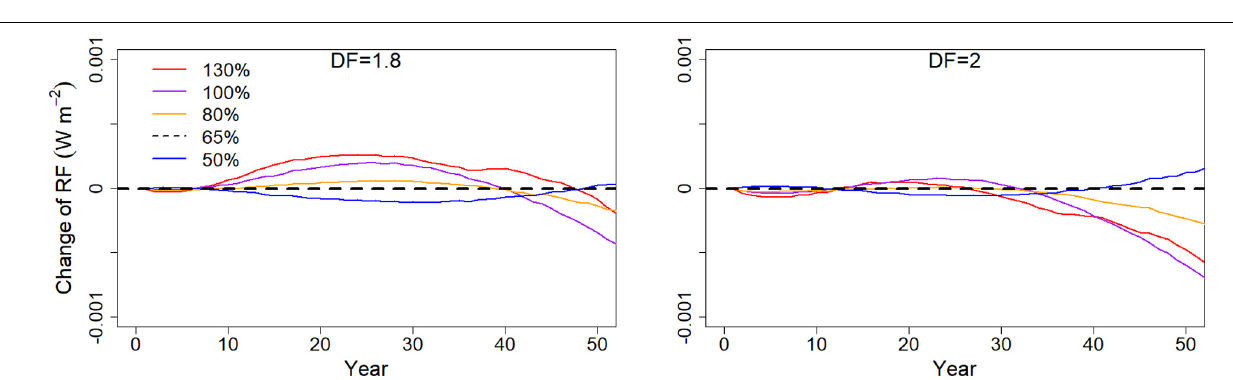
FIGURE 7 | The annual difference of the global radiative forcing (RF) between baseline (65% of CAI) and each scenario. Negative RF values indicate cooling impact compared with the baseline. Analysis was done in the current climate with the assumption that all harvested wood has a displacement factor (DF) value of 1.8 or 2.0 tC tC - 1 . Climate neutrality (in terms of RF) of each scenario compared with the baseline reached at the year they cross the